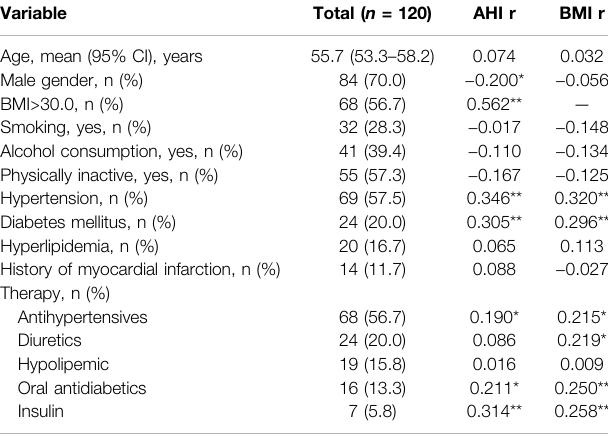
TABLE 1 | Demographic data, comorbidities and use of medications in the study population and their correlation with AHI and BMI.